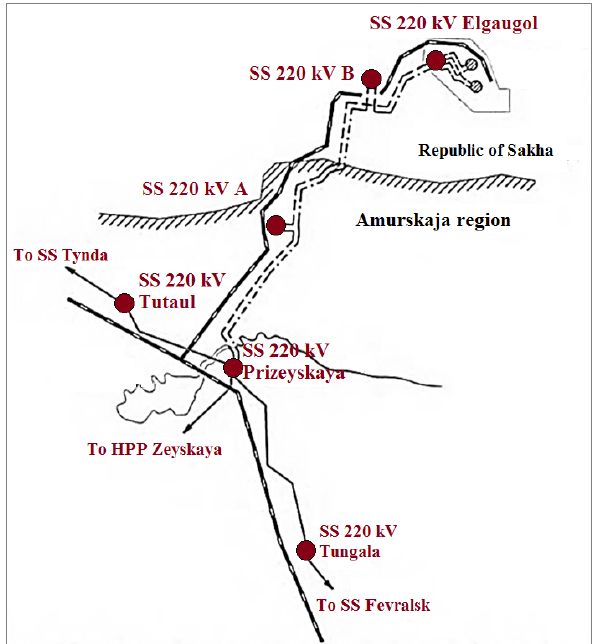
Figure 1. The electrical network of the intelligent